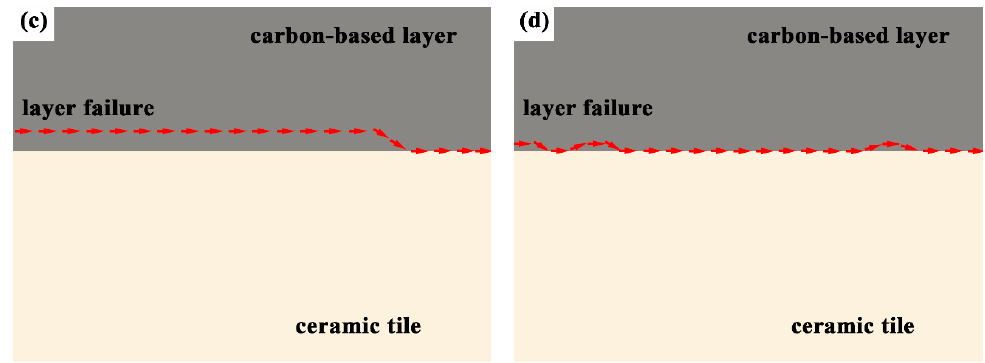
Figure 4. Backscattering electron images of the fracture surface of the samples with carbon-based suspension thickness of ( a ) 1.0 mm and ( b ) 1.2 mm after tensile adhesion strength test. Schematic diagrams of the failure mode of the ( c ) 1.0 mm samples and ( d ) 1.2 mm samples.